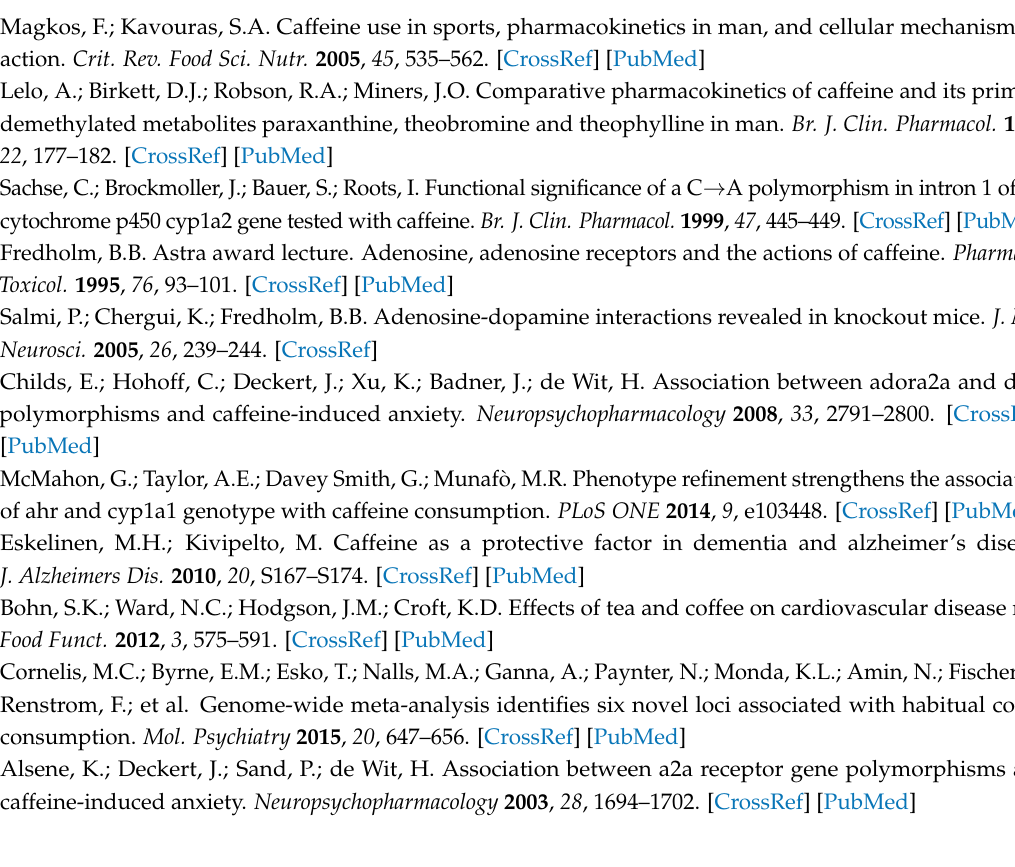
1373/s1, Figure S1: Algorithm, Figure S2: Excluded Studies; Figure S3: PRISMA Checklist; Figure S4: PRISMA